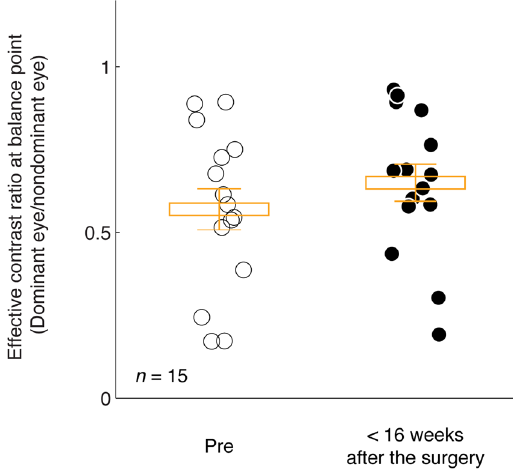
Figure 3. Sensory eye dominance before and within 16 weeks after the surgery. Each point represents the results of one subject. The average balance point and it’s standard error were marked using box and error bars for each time session.